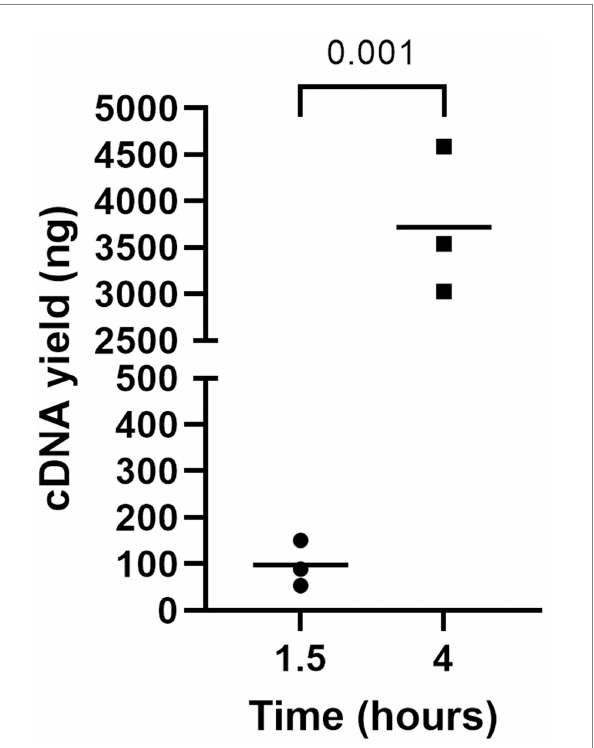
FIGURE 4 The impact of incubation time on cDNA yield by RCA. RCA amplified the circularized LCMV cDNA for 1, 5, or 4 h, and a Qubit 4 Fluorometer measured the yield of cDNAs. An unpaired t -test was used to determine the level of statistical significance. The calculated value of p are shown above the groups.